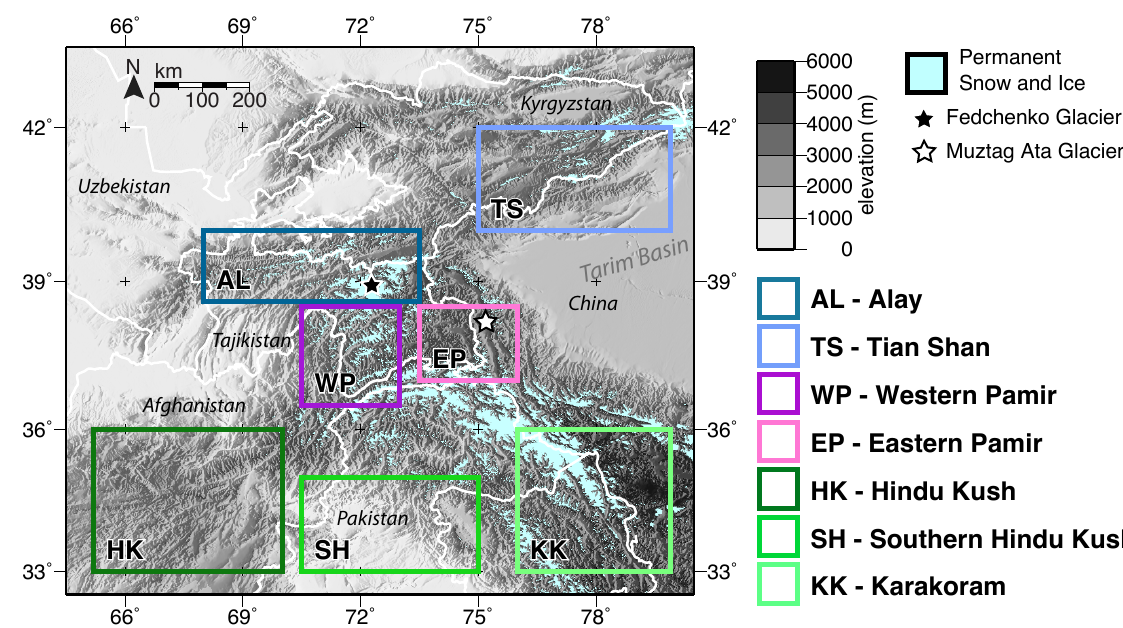
Figure 1. Study area with selected subdivided study sites. Glacier extent is approximated from MODIS MCD12Q1 land cover. Subdivided study sites were defined based on expected precipitation regimes and are named based on the dominant surrounding mountain